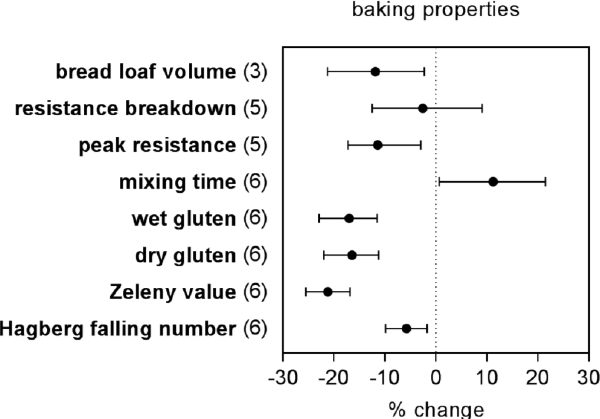
Figure 2. Meta-analysis showing the effect of eCO 2 on various baking properties using ambient CO 2 as the reference. Number of comparisons are given within brackets.